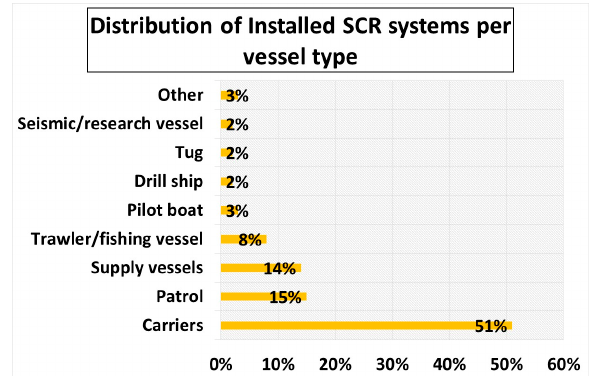
Figure 9. Distribution of installed SCR systems per vessel type. (Figure was genuinely generated using data from ref. [60]).